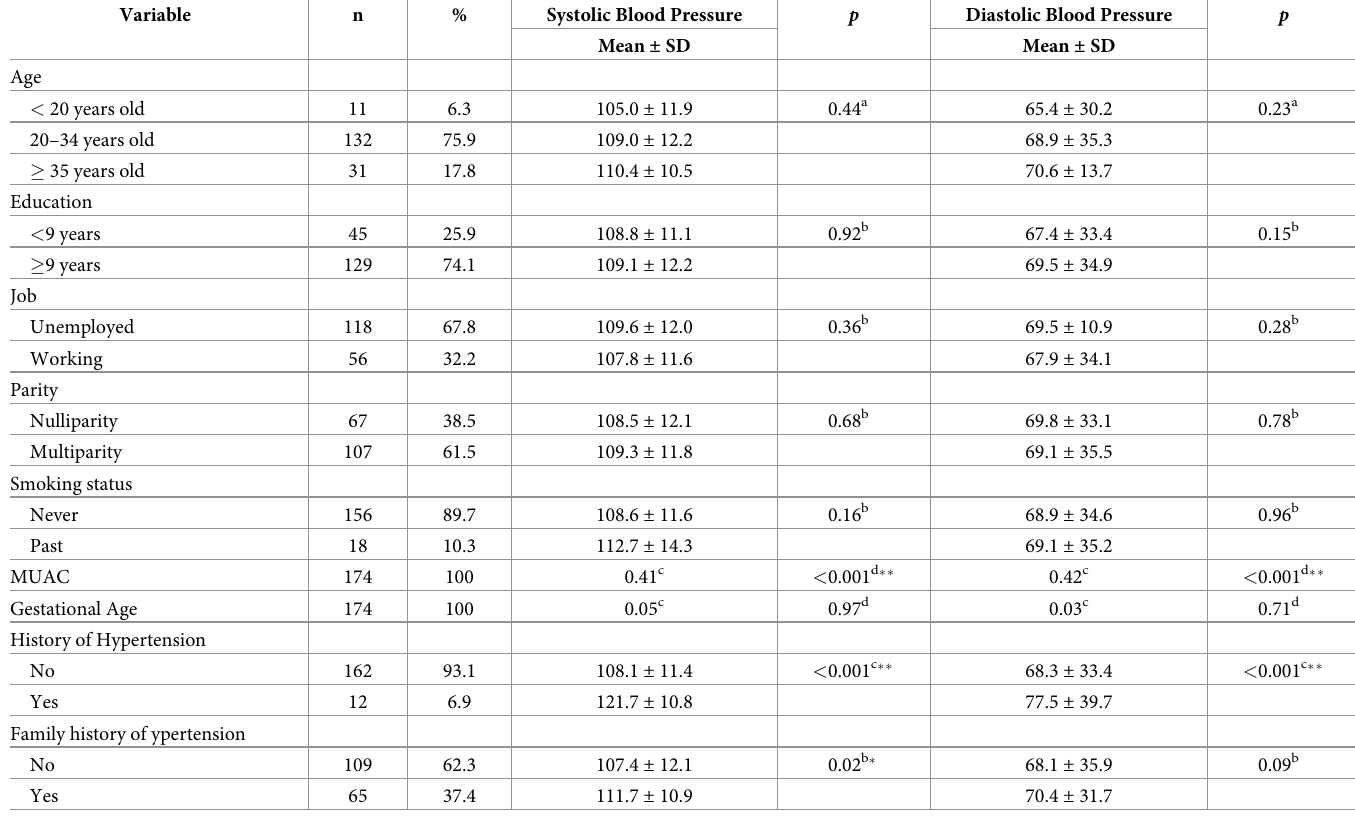
Table 4. Relationship of potential covariates and diet quality with blood pressure of pregnant women (n =